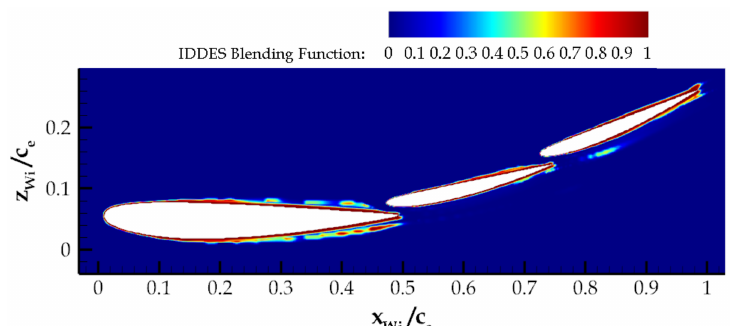
Figure 6. Contour showing the IDDES blending function at x Wi /c e = 0.648; when the function = 0, LES is used, when the function = 1, RANS is used.